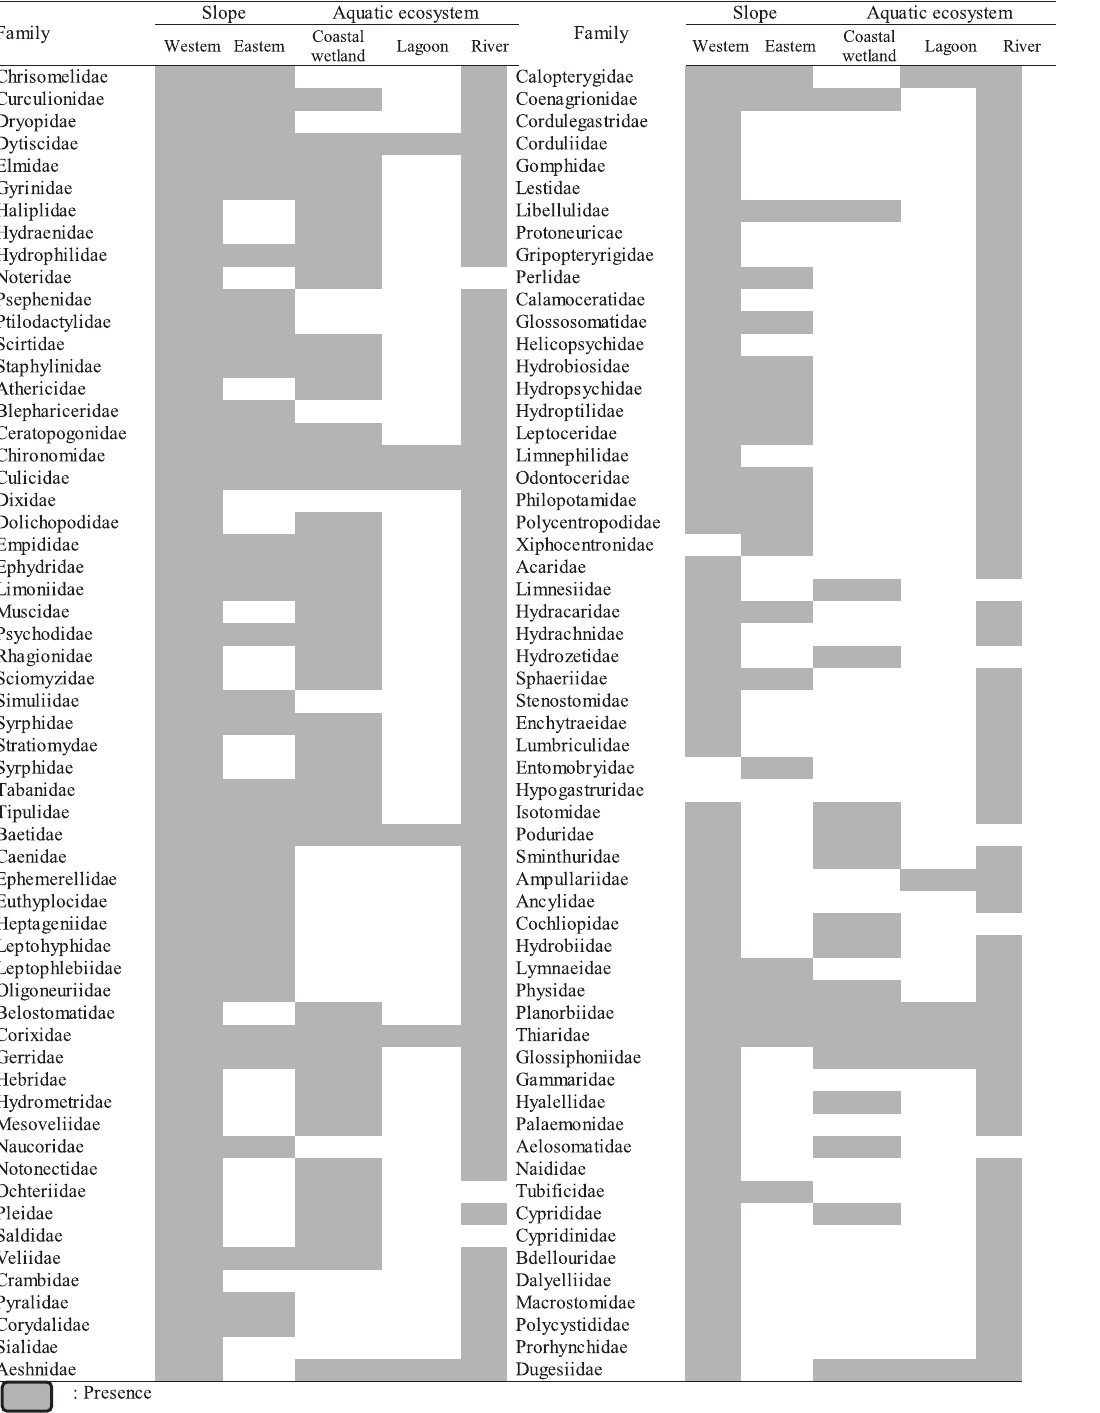
Frontiers in Environmental Science |